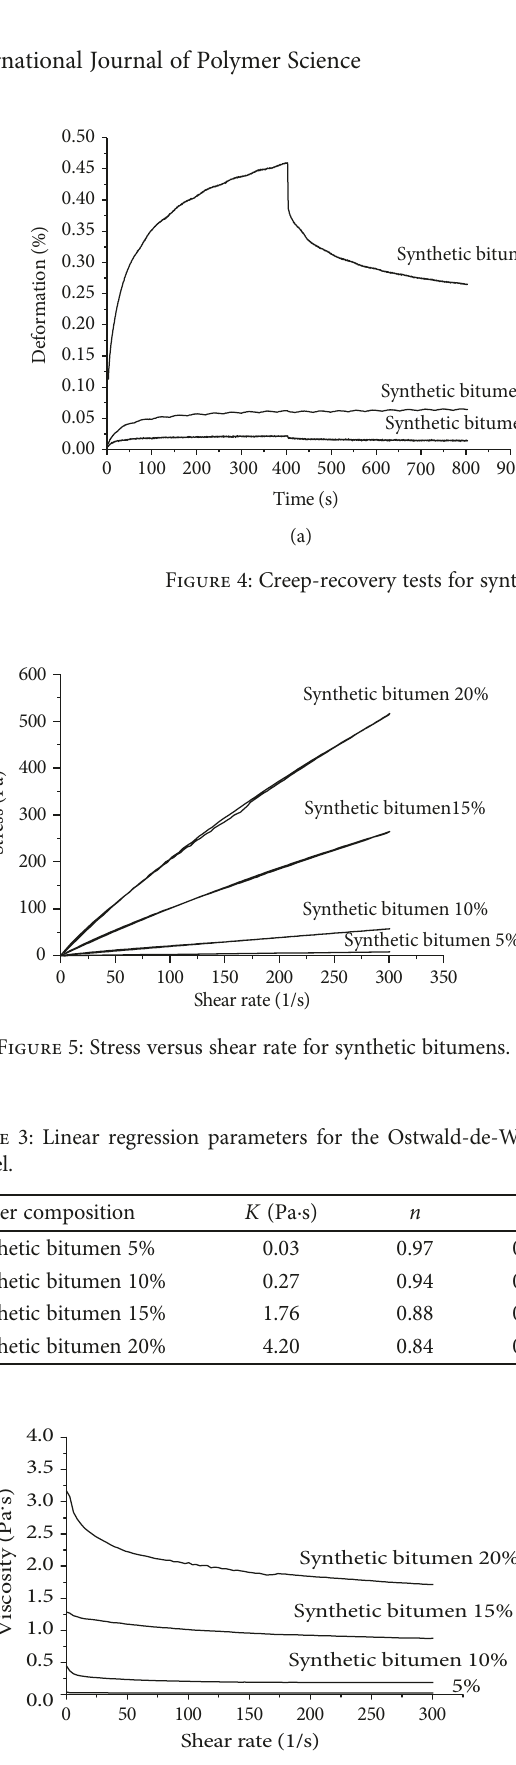
Figure 6: Viscosity versus shear rate for synthetic